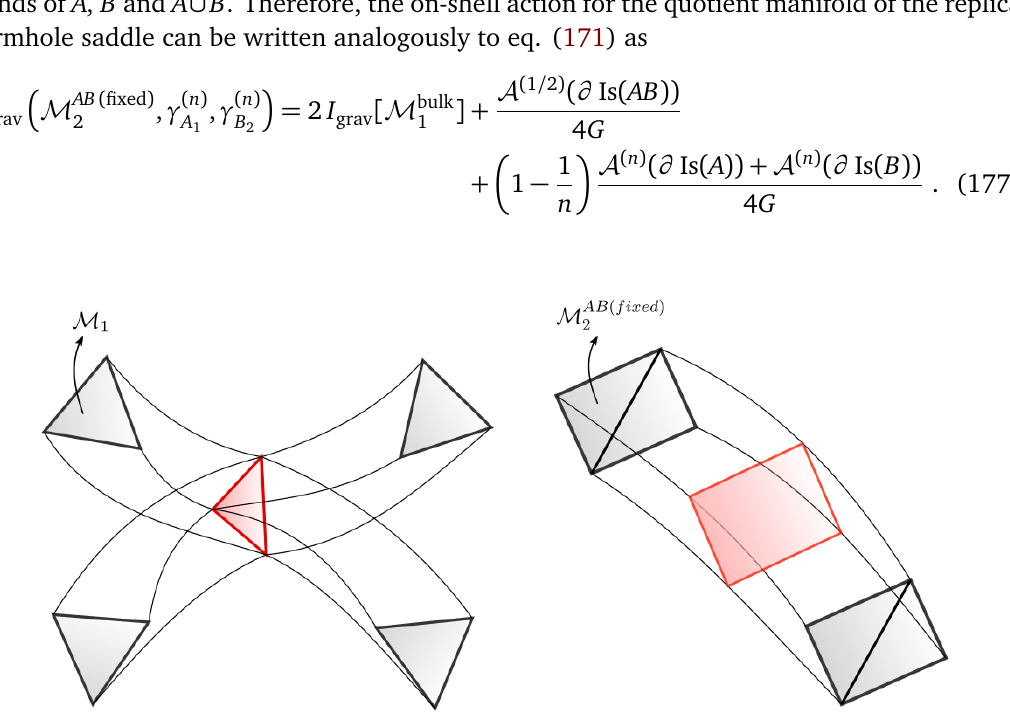
] on the right, is shown 2 n